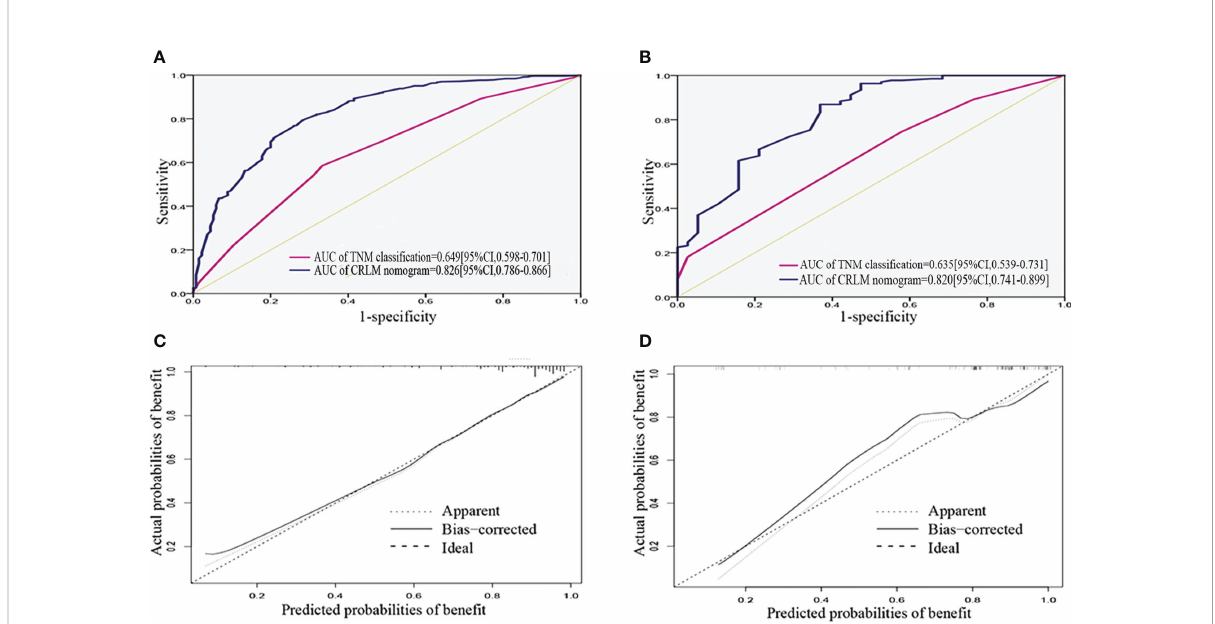
FIGURE 4 Validation of the nomogram. (A, B) ROC curve for discrimination in the training and validation cohorts. (C, D) Calibration plots for the actual (observed) and predicted probabilities of the nomograms in the training and validation cohorts. ROC, receiver operating characteristic curve.